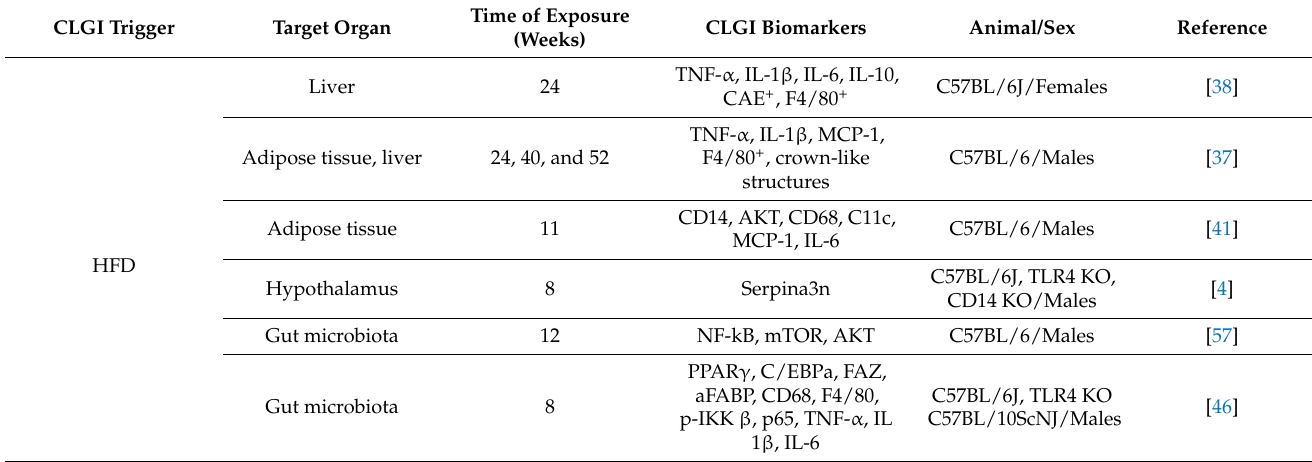
Table 3. Studies of CLGI (in reverse chronological order) resulting from high-calorie intake interventions in murine models. CLGI Trigger Target Organ